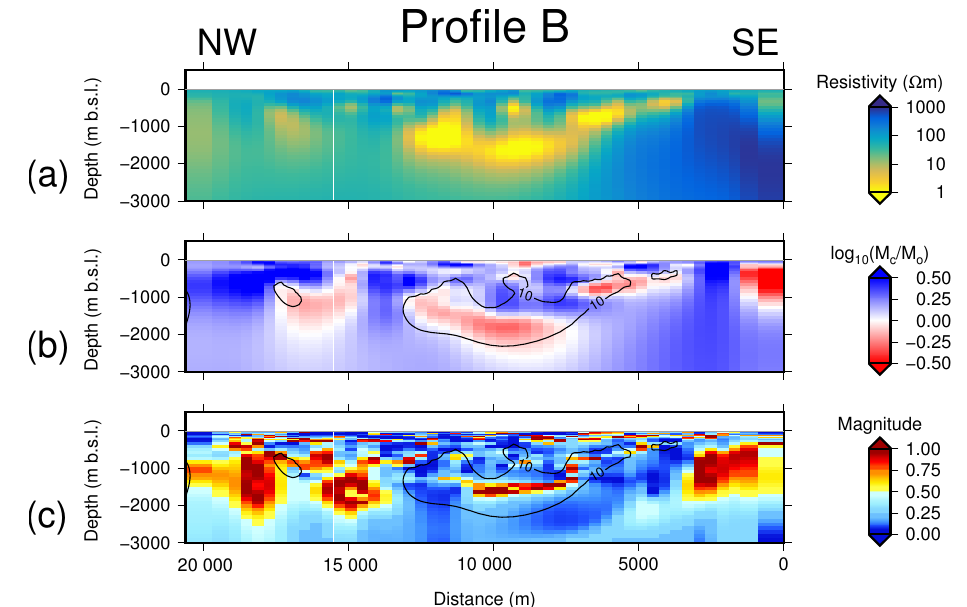
Figure 13. Profile B taken across the static-shift-corrected resistivity model M c (location shown in Figs. 1 and 11g). The resistivity is shown in panel (a) , the resistivity difference (cid:49)(M c ,M o ) is shown in panel (b) , and the cross-gradient of M c and M o is shown in panel (c) . Contours on the difference and cross-gradient plots show the 10 (cid:127) m contour. For presentation a vertical exaggeration of 1.5 is used.